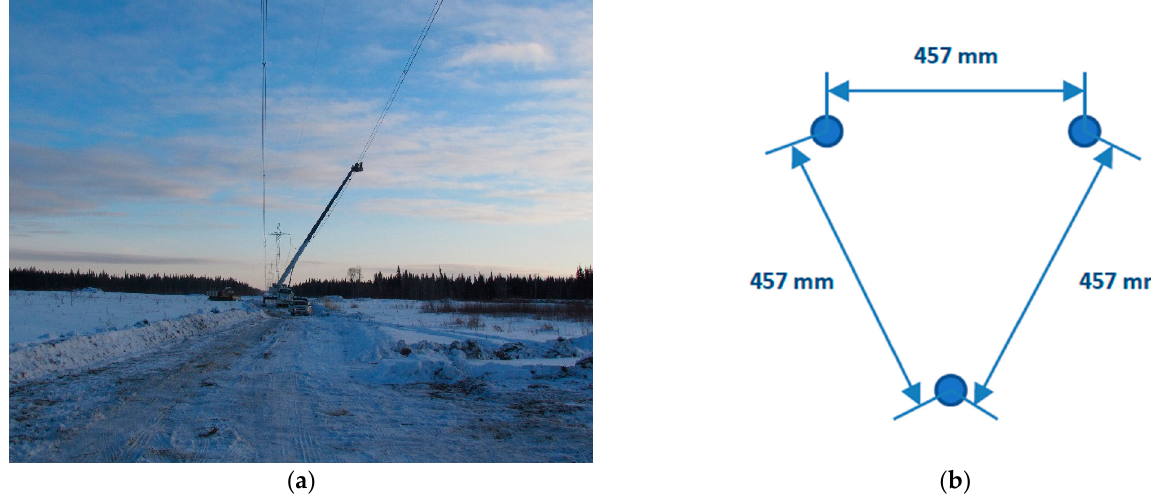
Figure 13. ( a ) Surroundings of the field test location; ( b ) Triple bundle